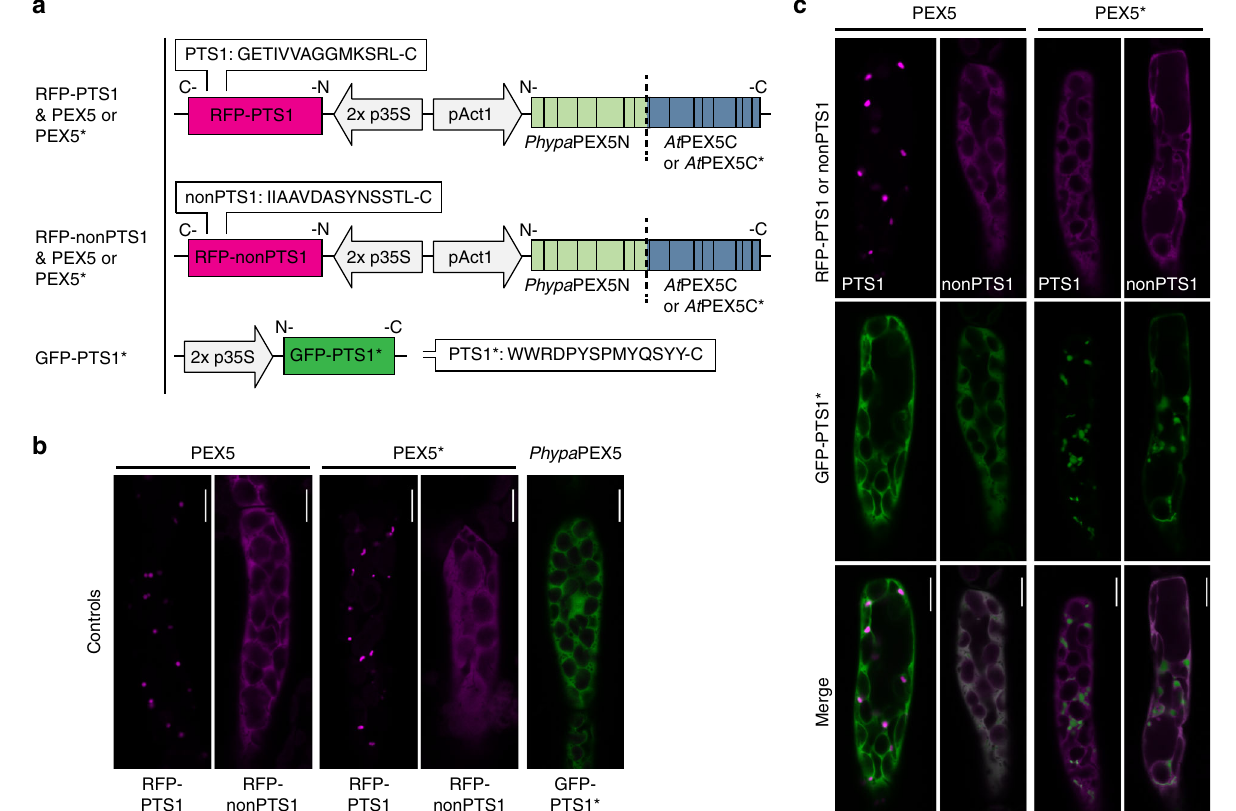
Fig. 3 In vivo transient expression. a Constructs produced for the in vivo expression in P. patens . RFP-PTS1 or nonPTS1 was on the same vector as the hybrid receptor ( Phypa PEX5N – At PEX5C (PEX5 or PEX5*)), and GFP-PTS1* was on a separate vector. b , c 36 – 48 h transient expression of constructs in P. patens cells. b Control experiments, expressing either RFP-PTS1 or -nonPTS1 & receptor alone, or GFP-PTS1* alone. GFP and RFP channels (merged) are shown for these images. c Co-transformation of both vectors (shown in part a of the fi gure). PEX5* imports GFP-PTS1* into peroxisomes, whereas PEX5 does not (under any of the conditions tested). Scale bars , 10 µ